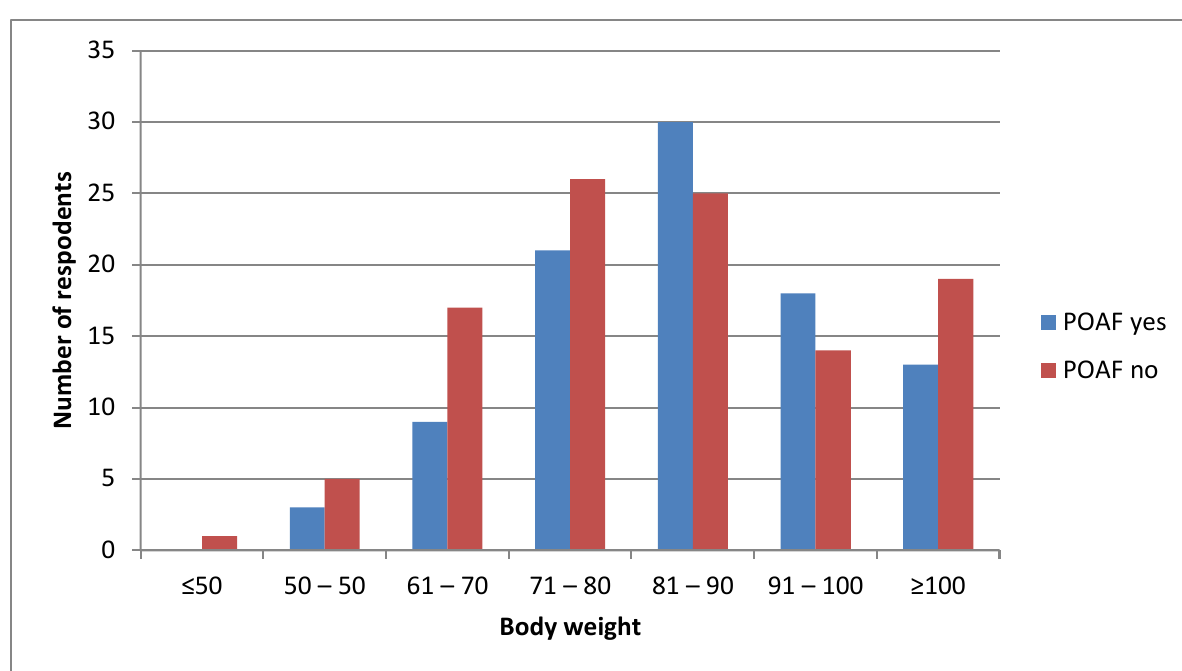
Figure 2. Prevalence of AF by body weight.